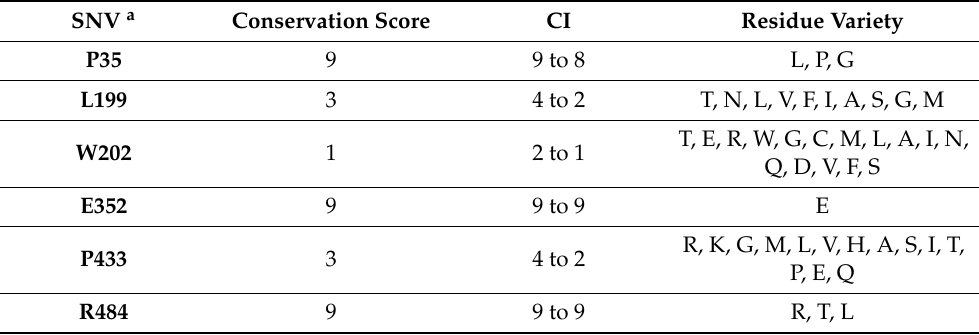
Table 4. ConSurf amino acid conservation score. The score is from 1 (variable) to 9 (conserved). CI: Confidence interval of the score. a PDB ID 4Y8W. Details of any known variations in the amino acid positions studied are given in Table S3 (Supplementary